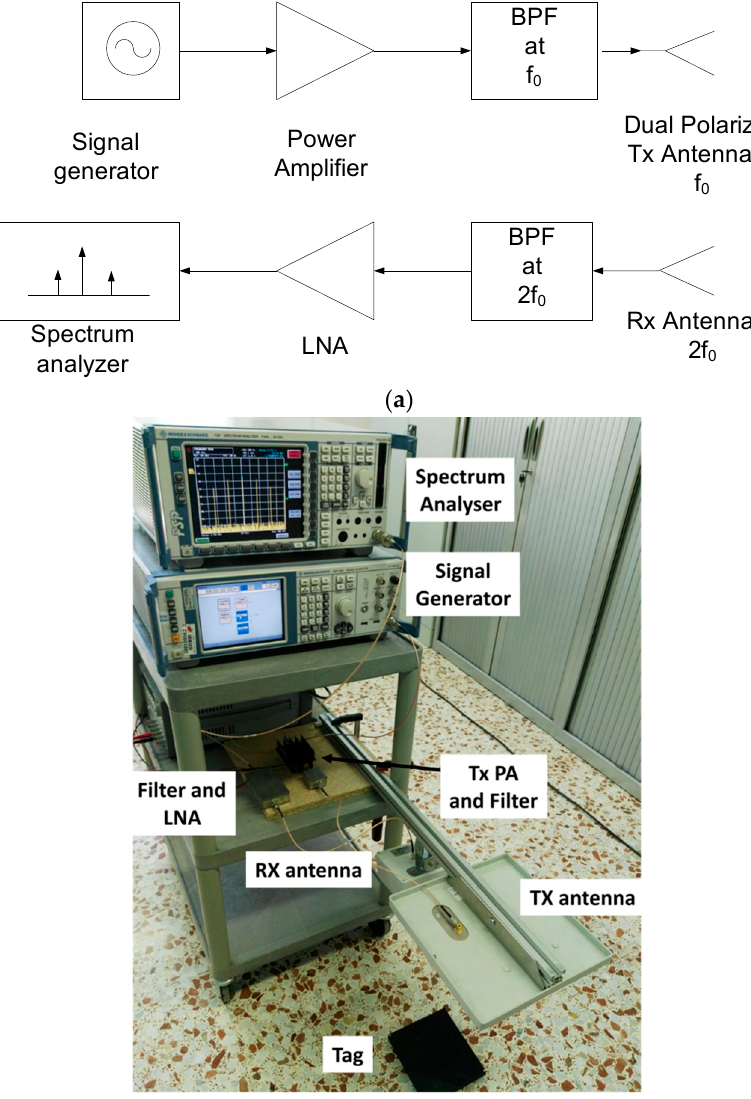
Figure 6. ( a ) Block diagram of the experimental setup based on laboratory instrumentation and ( b ) photograph. ( b )